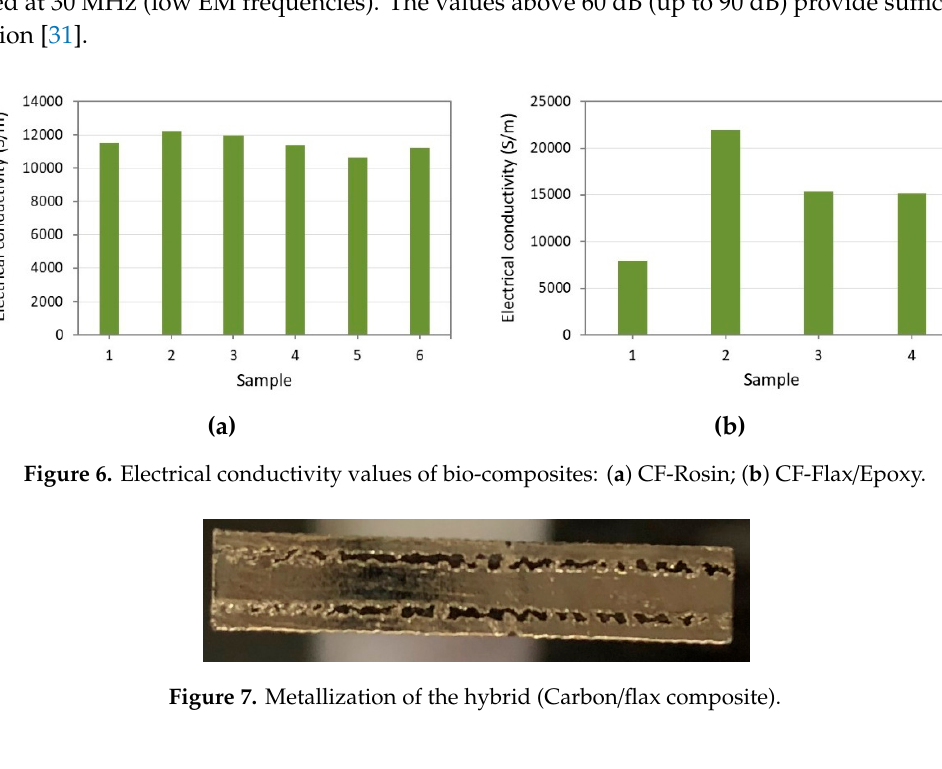
Figure 7. Metallization of the hybrid (Carbon/flax composite).